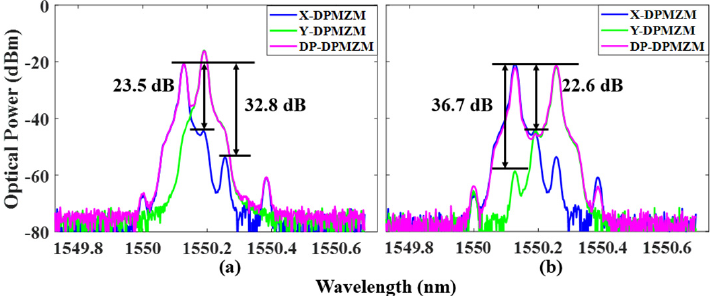
Figure 3. Measured output optical spectra of the X − DPMZM, Y − DPMZM, and DP − DPMZM with ( a ) fundamental frequency mode and ( b ) doubled frequency mode. ( a ) fundamental frequency mode and ( b ) doubled frequency